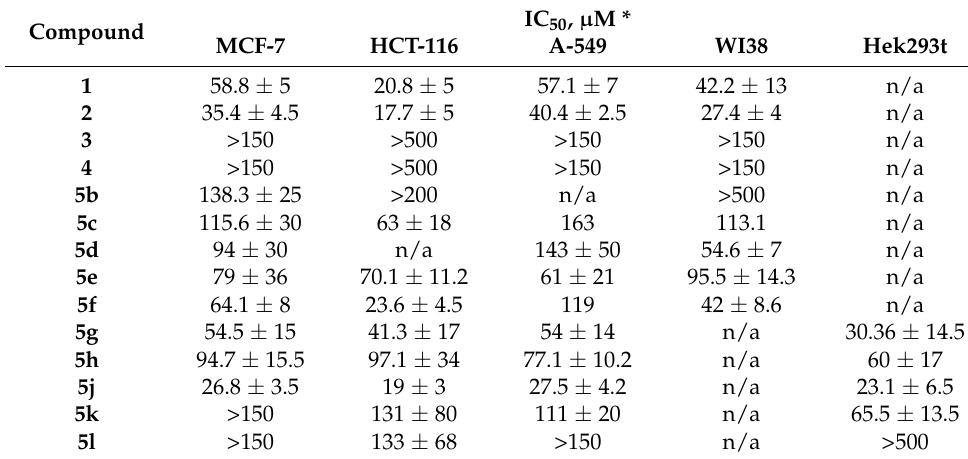
Table 4. Cytotoxicity of isoxazoline